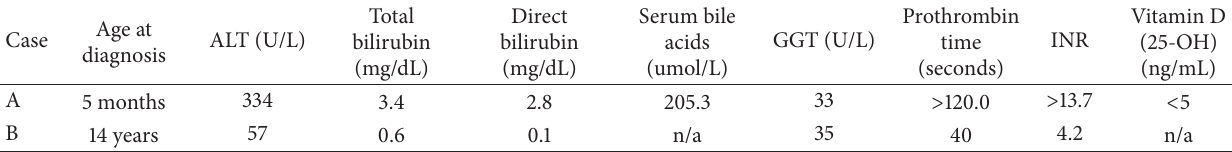
Table 1: Initial presenting clinical and laboratory data.